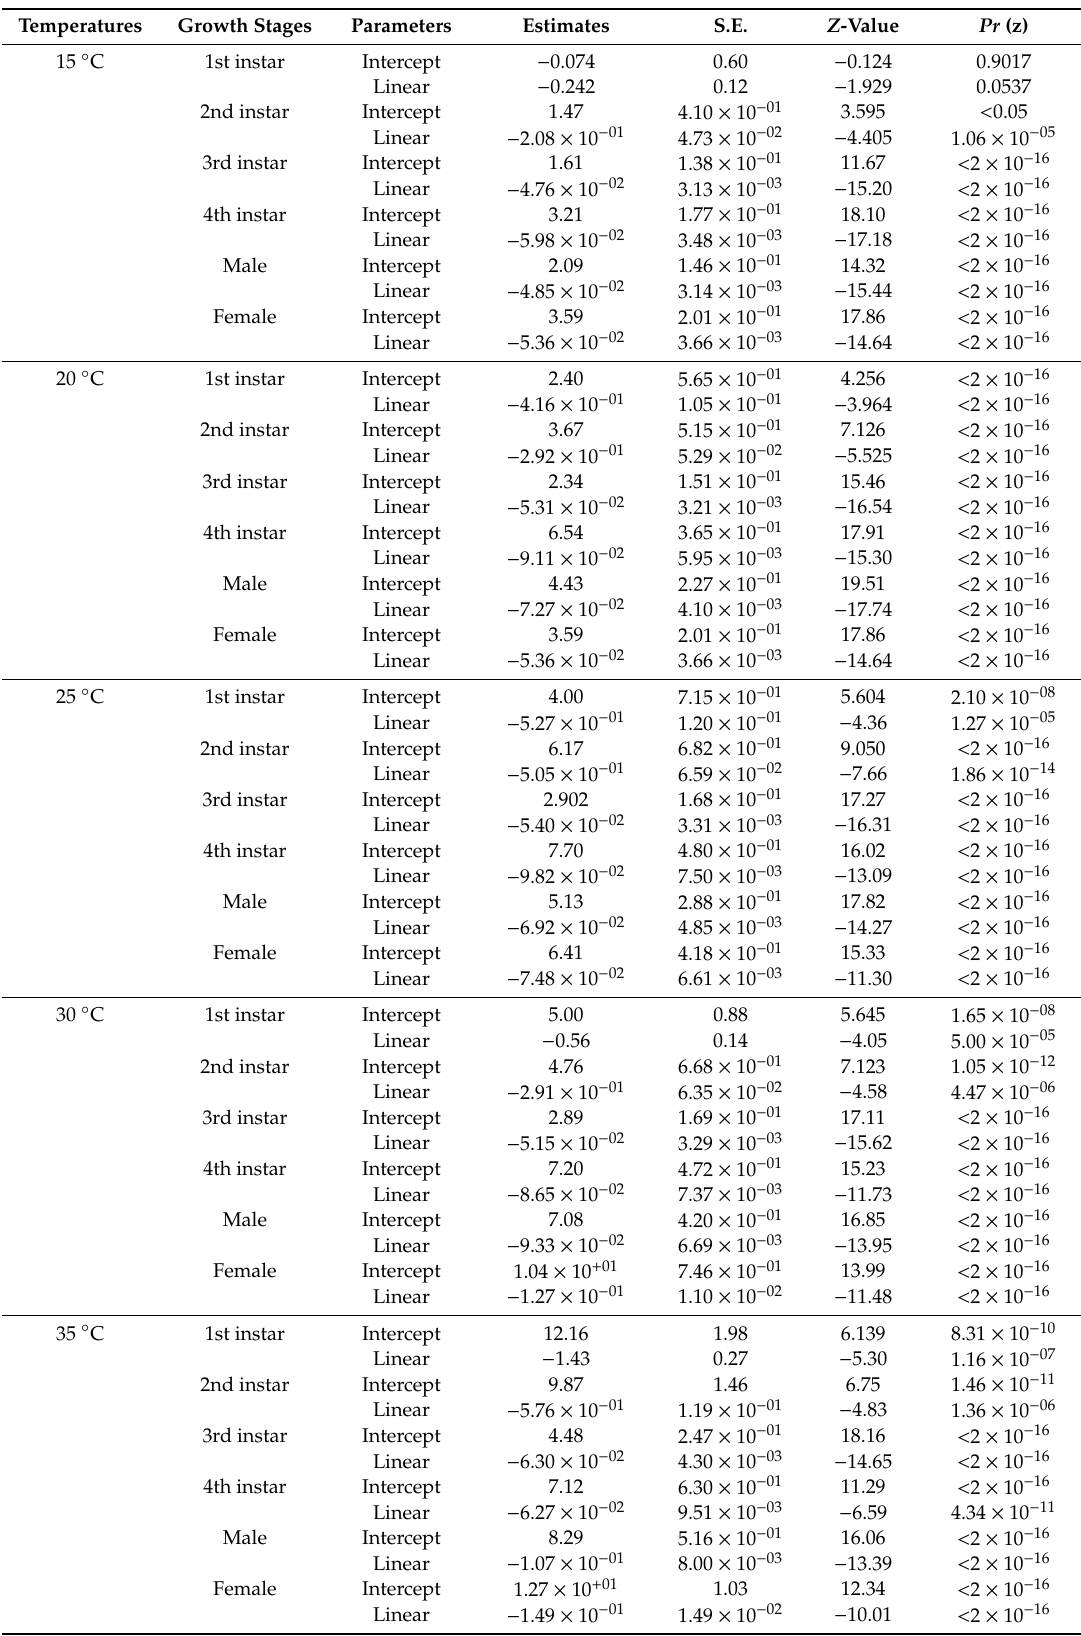
Table 3. Maximum likelihood estimates from logistic regression analyses of the proportion of prey eaten by di ff erent stages of Harmonia axyridis against initial number of Spodoptera litura eggs o ff